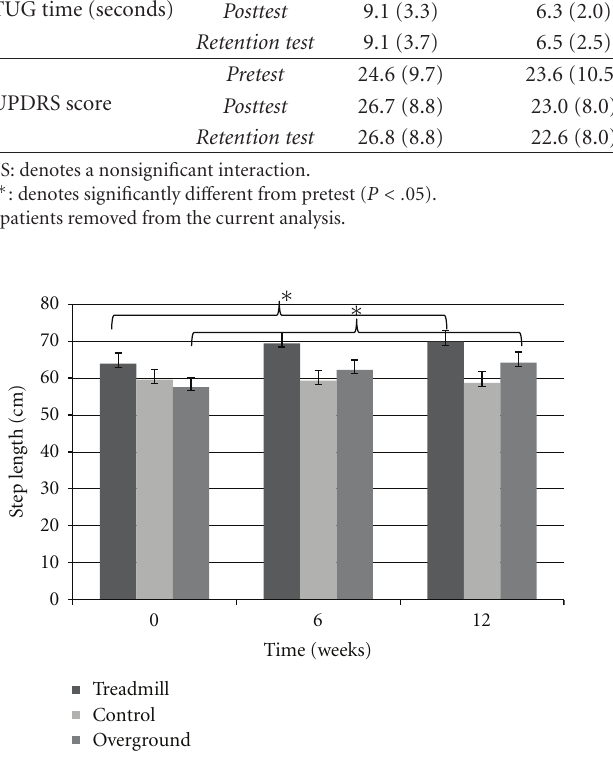
Figure 1: Step length significantly improves in TG and OG after six weeks (posttest) and is maintained after 12 weeks (retention test).